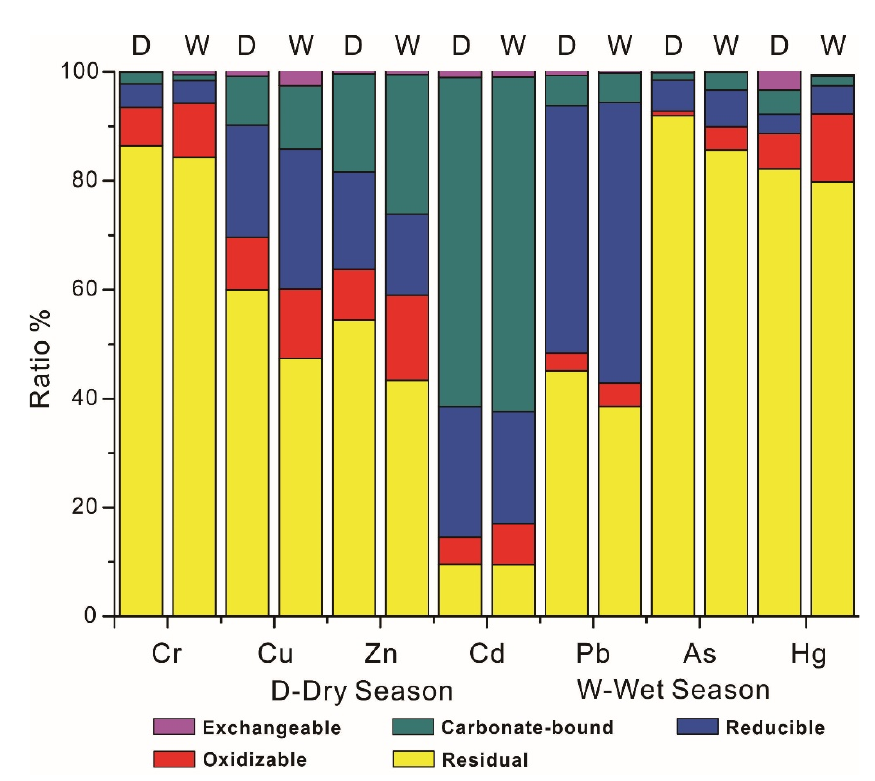
Figure 2. The speciations of metals in sediments of Liujiang River